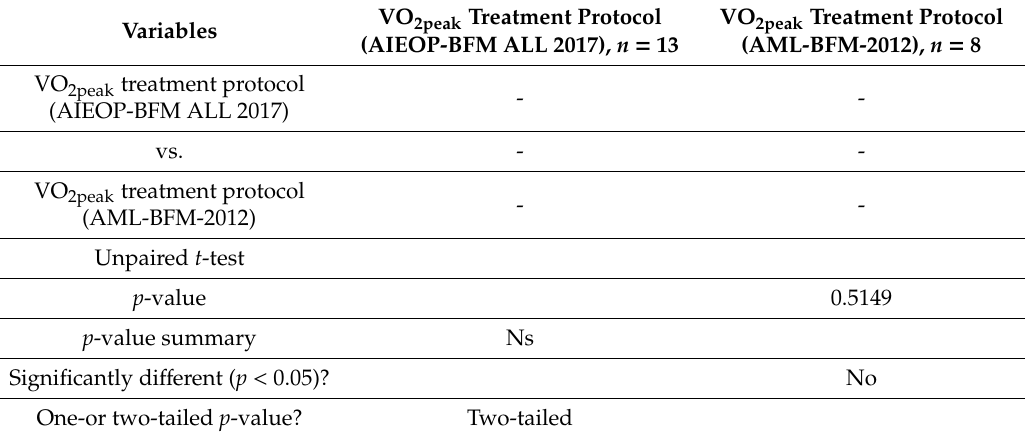
Table 4. The relationship between the level of exercise capacity (VO 2peak ) and the treatment protocol (AIEOP-BFM ALL 2017;